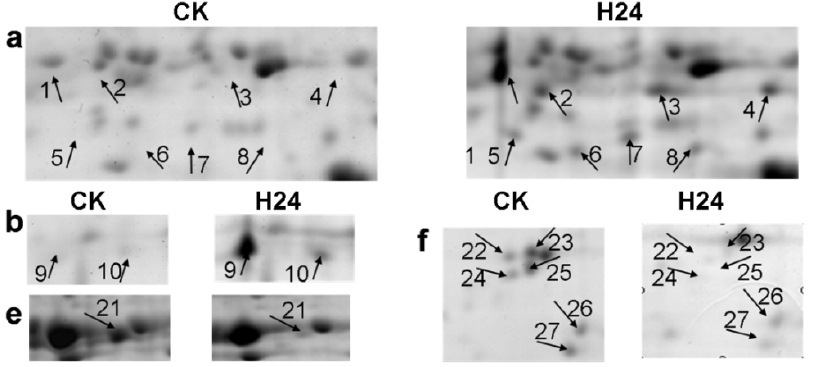
Figure 3. Magnified regions of differentially expressed proteins in P. ternata